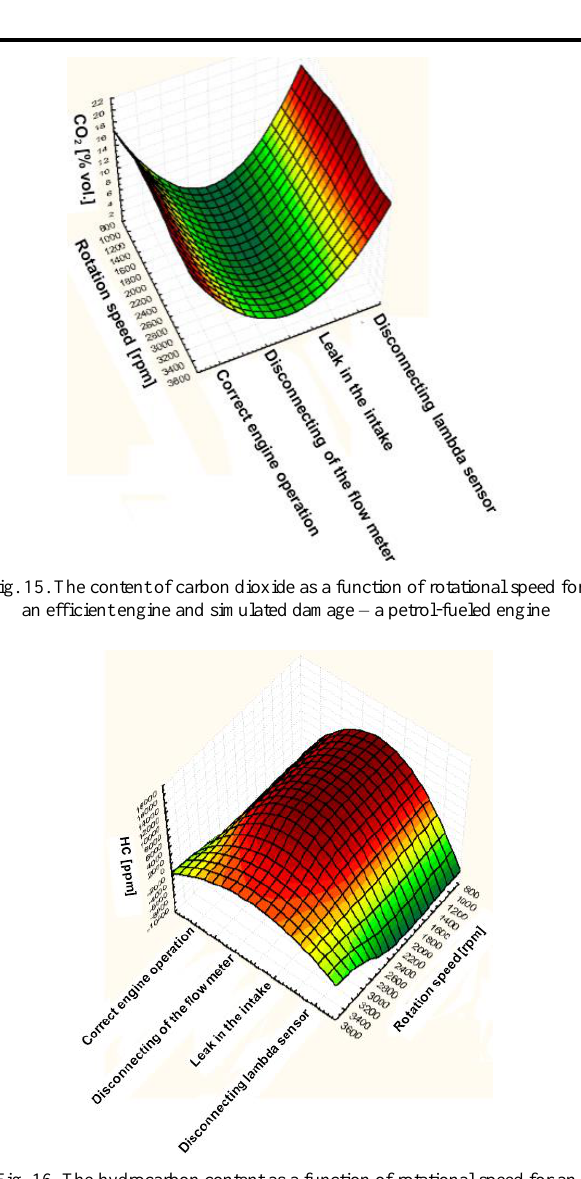
Fig. 16. The hydrocarbon content as a function of rotational speed for an efficient engine and simulated damage – a petrol-fueled engine